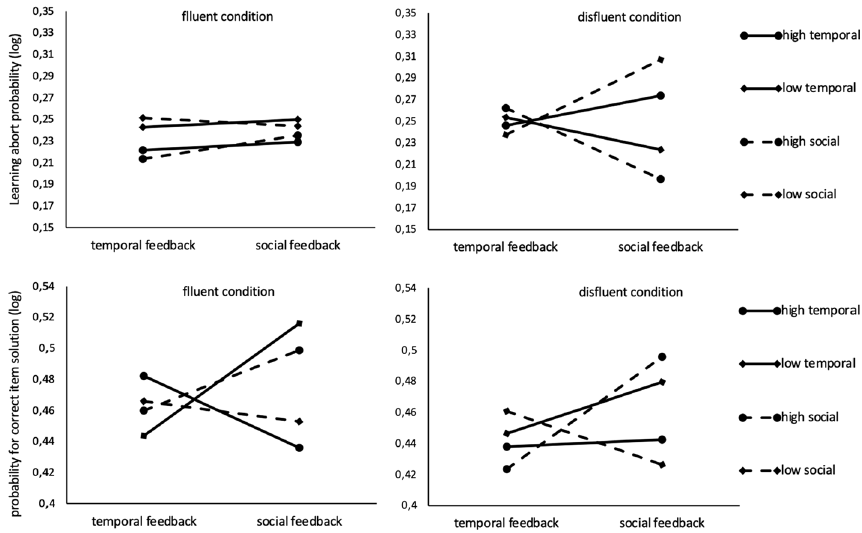
Fig. 4 Effects of preferences for comparison standards and framed feedback under fluent and disfluent conditions. Upper row: Fit effects on abortion probability as an inverted measurement for learning persistence and. Lower row: Fit effects probability for correctly solved exercises as an indicator for learning